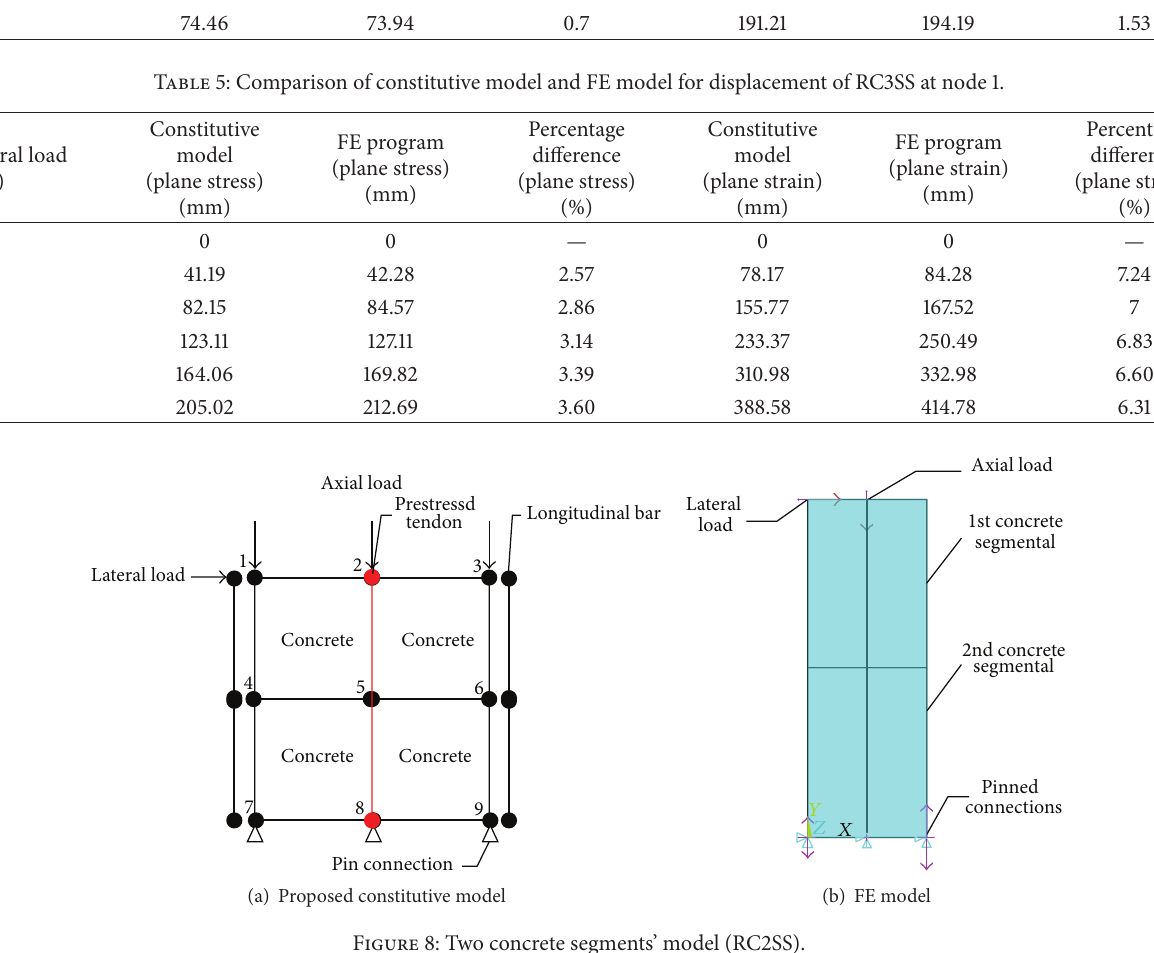
Figure 8: Two concrete segments’ model